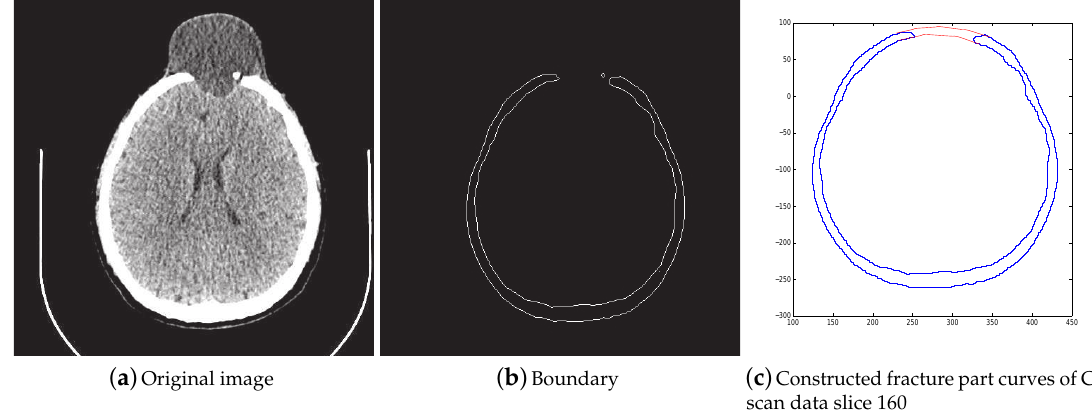
Figure 9. CT scan data slice